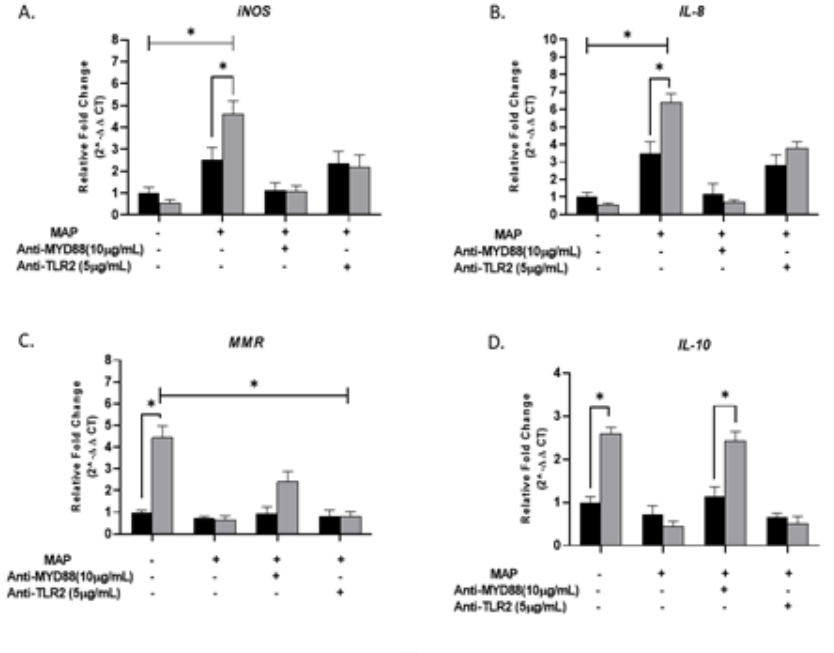
Figure 6. Effect of nicotine/MAP infection on inflammatory response following TLR2 and MyD88 inhibition in vitro. MAP-infected macrophages were preincubated with 10 µg/mL of T6167923 or 5 µg/mL of MMG11, following by nicotine treatment for 24 h. Expression of iNOS ( A ), IL-8 ( B ), MMR ( C ) and IL-10 ( D ) were measured by RT-PCR. All experiments were performed in duplicates. ( + ): Presence, ( - ): Absence. * p < 0.05.